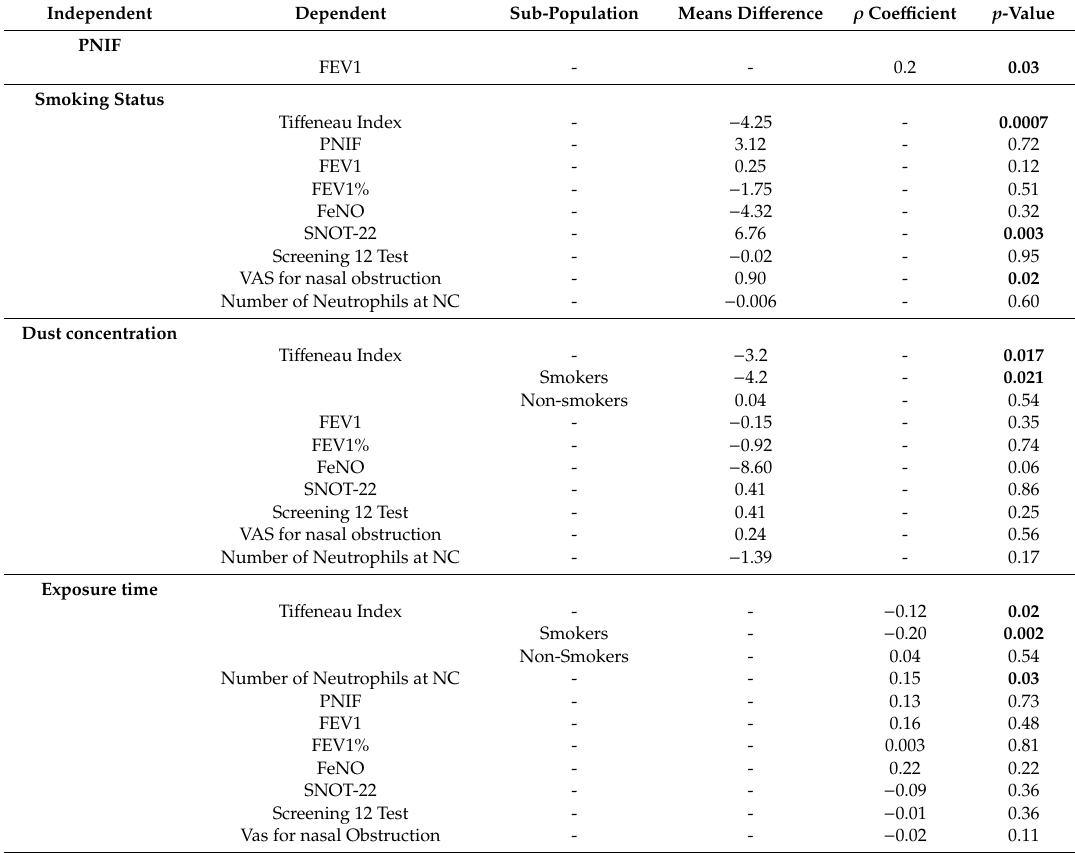
Table 5. Main study